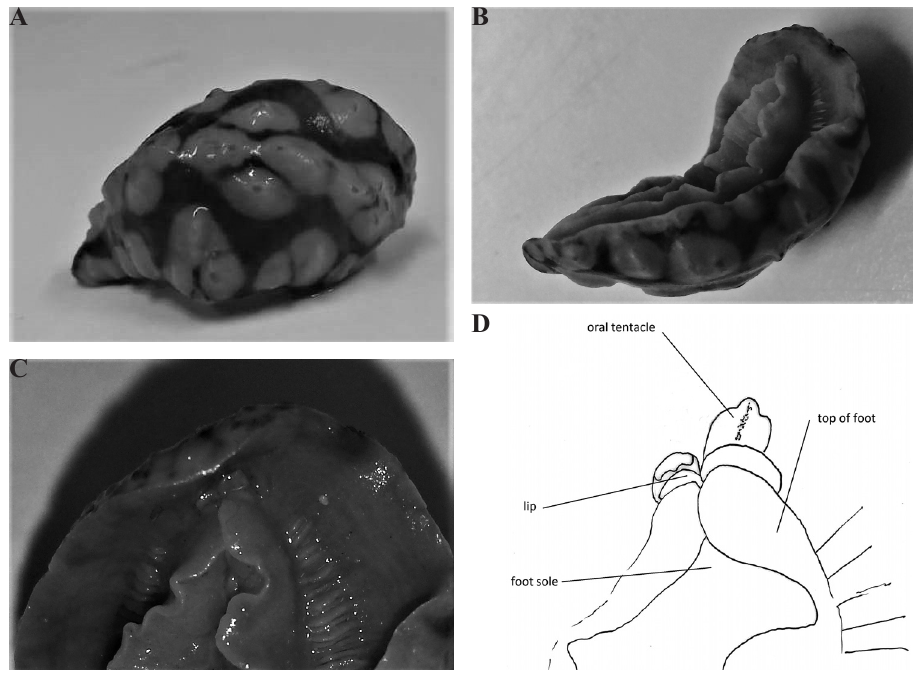
Figure 1. Phyllidiella amphitrite sp. nov., holotype SMF 360585 A dorsal view B ventral view C detail of oral tentacles and anterior foot margin D drawing of oral tentacles, ‘lips’, and anterior foot margin. creamy white base. They are present as a single series along the submargin and the margin is smooth and